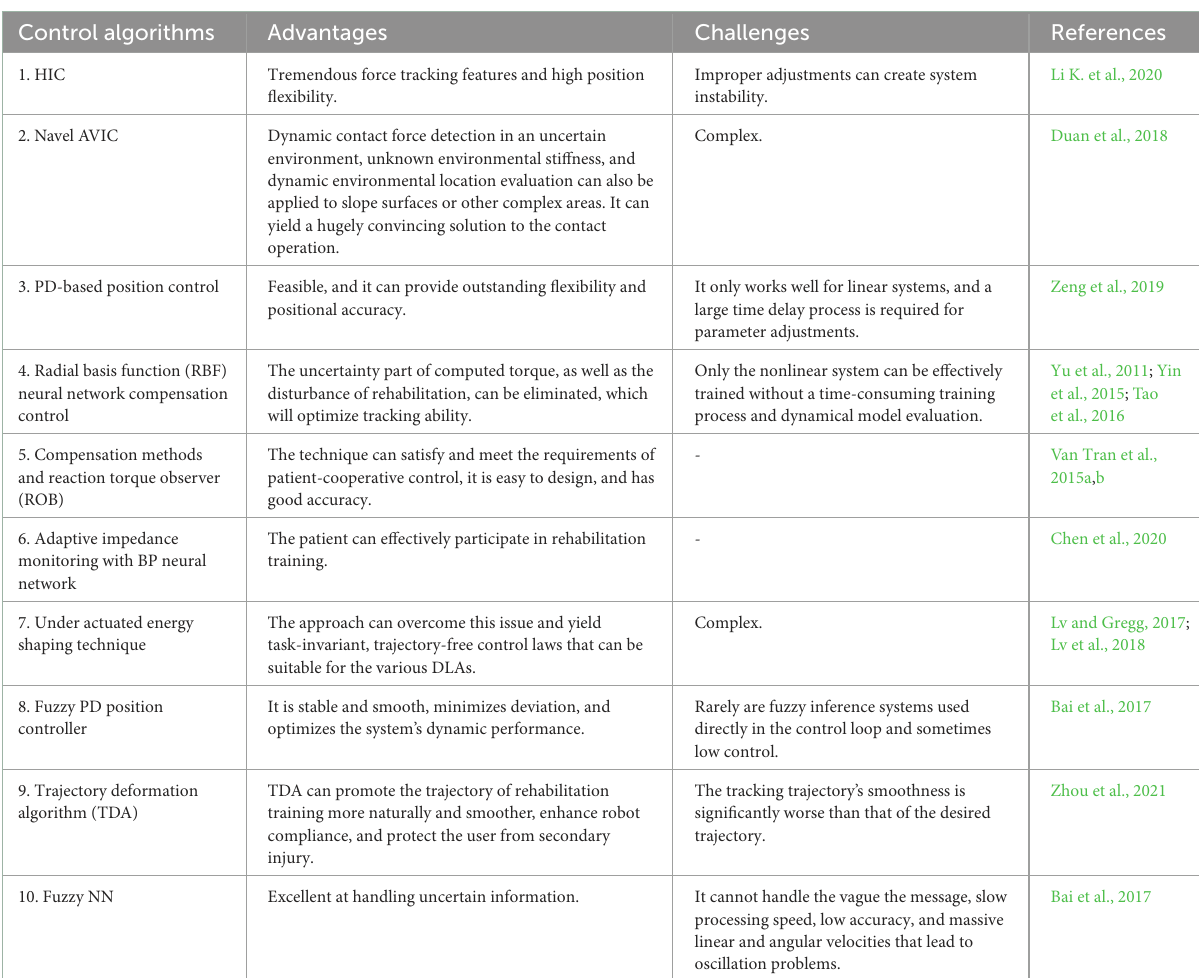
TABLE 2 Comparison of various conventional cooperative